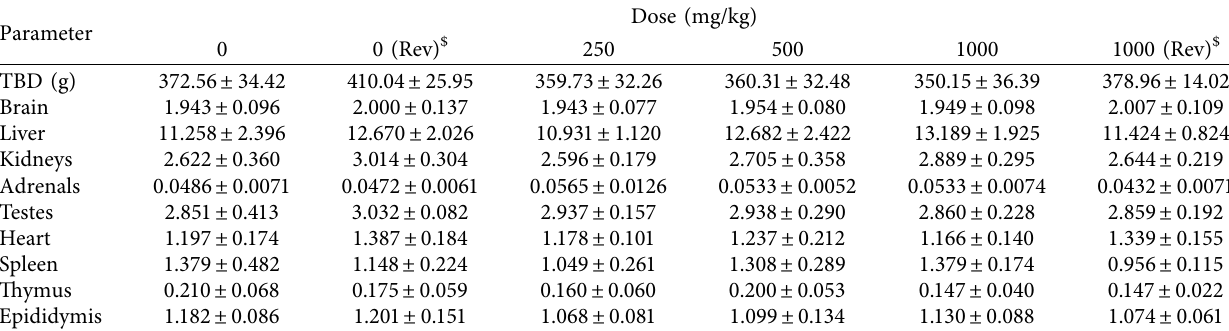
Table 9: Effect of GutGard on absolute organ weights (g) of male rats during 90D oral toxicity study.